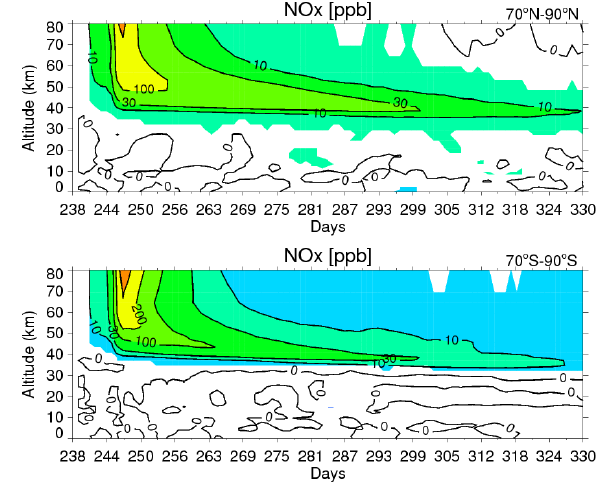
433 Fig. 2: Upper panel : Evolution of changes in NO x zonal mean mixing ratio profile in the polar re- 434 Fig. 2. Upper panel: evolution of changes in NO x zonal mean mix- gions (70°-90°N). Lower panel : same for 70°-90°S. Colors indicate areas with at least 95 % statisti- 435 cal significance. Upper panel contour levels: 10, 30, 100, 200 ppbv. Contour levels lower panel: 10, 436 ing ratio profile in the polar regions (70–90 ◦ N). Lower panel: same 30, 200, 300 ppbv. 437 for 70–90 ◦ S. Colors indicate areas with at least 95% statistical sig- nificance. Upper panel contour levels: 10, 30, 100, 200 ppbv. Con- tour levels lower panel: 10, 20, 200, 300ppbv.